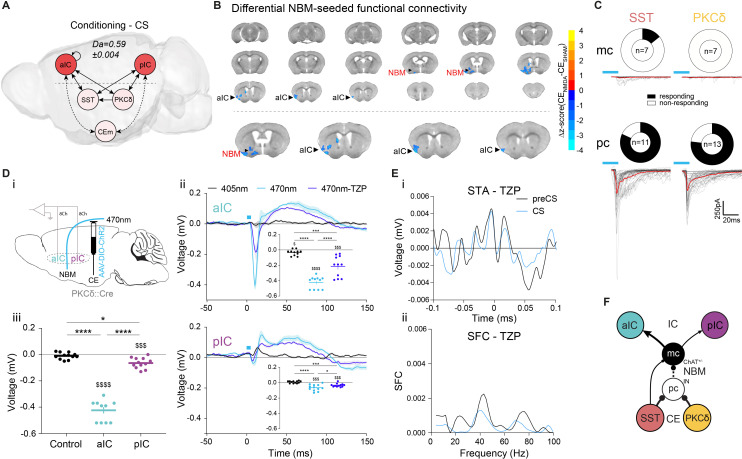
Basal forebrain NBM mediates bottom-up recruitment of IC activity.(A) (i) Network depicting significant TE during CSs generated from data acquired from RC and FC stages. RF decoder accuracy (Da) for decoding CSs at RC and FC stages shown above network. Node color corresponds to feature importance from RF classification (Figure 2—figure supplement 2Aiii). (B) Chronic CENMDA reduced NBM resting-state functional connectivity to the right aIC compared to the CESHAM group. Two-sample t-test between CESHAM (n = 4) and CENMDA (n = 3) groups, followed by Gaussian Random Field Theory Multiple Comparison Correction (voxel-level p-value=0.05, cluster-level p-value=0.05). Differential z-score between CENMDA and CESHAM indicates depleted correlation (blue). (C) Fraction of magnocellular (mc)/parvocellular (pc) neurons in the NBM that responded with IPSCs upon optogenetic stimulation of CESST or CEPKCδ input. (D) (i) In vivo optogenetic stimulation of the right CEPKCδ–NBM pathway in two IC multi-site recorded, freely moving animals. (ii) Peri-laser stimulus time histograms of aIC (top) and pIC (bottom) channel-averaged LFP traces averaged over 60 (405, 470 nm) and 40 (470 nm-TZP) laser pulses. Traces represent averages of all available channels in aIC (11Ch) and pIC (12Ch). Insets depict respective minima of LFP traces within 20 ms after laser pulse onset. Significant one-way RM ANOVA for aIC (F1,116,11,16=153.00, p<0.0001) and pIC (F1,340,14,74=23.60, p<0.0001). (iii) Quantification of IC LFP minima upon CEPKCδ–NBM stimulation under control conditions. Significant one-way ANOVA (F2,32=209.40, p<0.0001). All data presented as mean ± SEM. Holm-Sidak post hoc analysis was used for comparison between treatments/regions (*) and one-sample t-test for individual differences to zero ($), */$p<0.05, ***/$$$p<0.001, ****/$$$$p<0.0001. Full statistical report in Appendix 1—table 1. (E) (i) STA from the recall stage of 200 ms pIC LFP traces centered around aIC spikes after systemic administration of TZP. (ii) SFC resulting from pIC LFP power-normalized STA from (i). (F) Circuit model of the bottom-up IC↔CE/NBM pathway consistent with experimental data. Dotted line represents a connection not assessed, but consistent with previous studies (Jolkkonen et al., 2002; Kapp et al., 1994).Figure 4—source data 1.IC LFP responses upon optogenetic CEPKCδ–NBM stimulation.